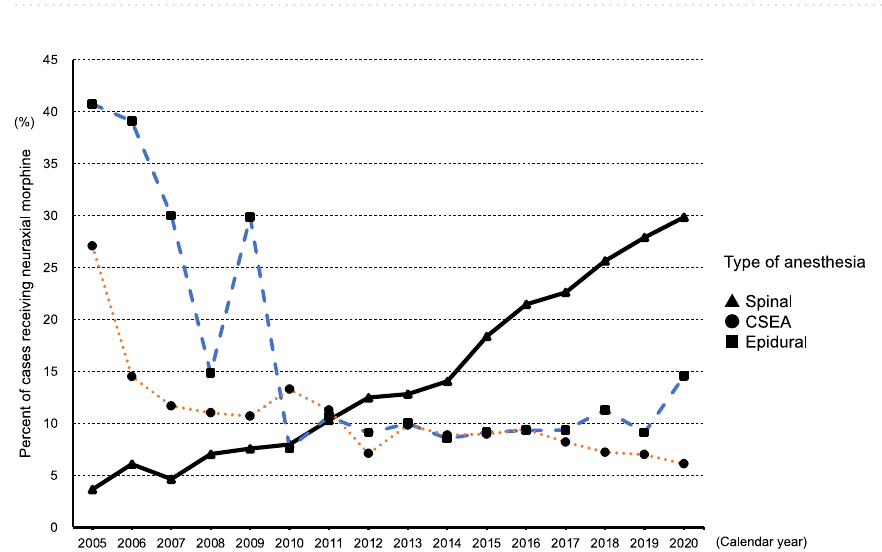
Figure 1. The annual rates of neuraxial morphine use and type of surgery (overall, elective, and emergency) from 2005 to 2020.